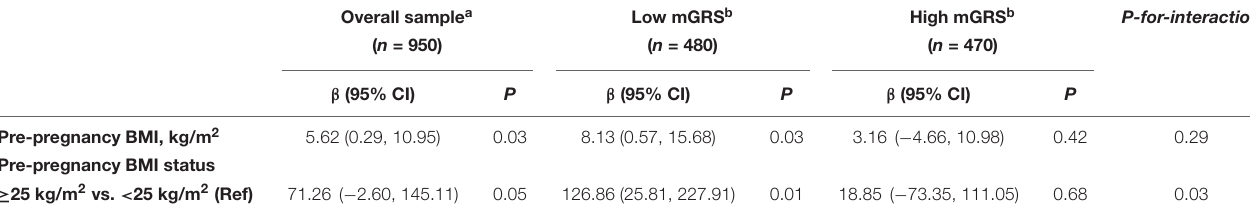
TABLE 6 | Association of maternal pre-pregnancy body mass index with birthweight stratified by maternal GRS. Overall sample a Low mGRS b High mGRS b